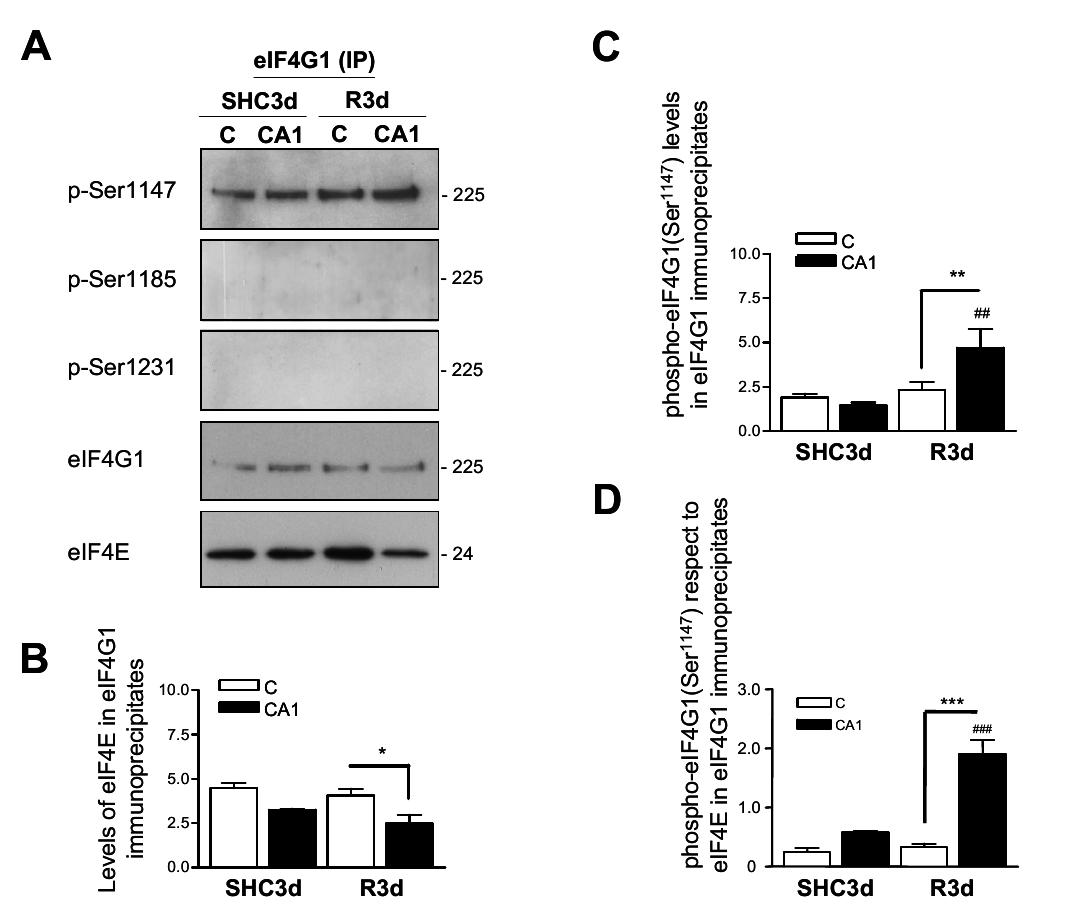
Figure 4. Association of eIF4E to eIF4G1 phosphorylated at Ser 1147 in eIF4G1 immunoprecipitates. ( A ) Samples of cerebral cortex (C) or hippocampal CA1 region from control (SHC3d) and ischemic animals with reperfusion (R3d), were immunoprecipitated with anti–eIF4G1 (N-20) antibody and eIF4G1-associated proteins analyzed by SDS-PAGE followed by Western blotting for anti-phospho-eIF4G1 Ser 1147 (p-Ser1147), anti-phospho-eIF4G1 Ser 1185 (p-Ser1185), anti-phospho-eIF4G1 Ser 1231 (p-Ser1231), anti-eIF4G1 (H-2) (eIF4G1) and anti-eIF4E (eIF4E) antibodies. Among eIF4G1 phospho-forms, only eIF4G1 phosphorylated at Ser 1147 was detected. Numbers on the right indicate the apparent molecular mass in kDa, from protein markers. The figures are representative results of 4–6 independent experiments from 4–6 animals. Full original images of the Western blots are shown in the Supplementary Material (Figure S4). ( B ) Quantification of eIF4E levels, and ( C ) quantification of eIF4G1 phosphorylated at Ser 1147 , with respect to immunoprecipitated eIF4G1 levels (ratios). ( D ) Relative levels of eIF4G1 phosphorylated at Ser 1147 with respect to eIF4E levels in eIF4G1 immunoprecipitates. Bar graphs represent the mean of 4–6 independent experiments from 4–6 animals; error bars indicate SE. Statistical significance were performed by Newman–Keuls post-test (## p < 0.01; ### p < 0.001) or by Student’s t-test (* p < 0.05; ** p < 0.01; *** p < 0.001), after significant ANOVA ( p < 0.05), compared with their respective control, or between the cerebral cortex and CA1 samples (indicated by lines). IP, immunoprecipitated fraction.